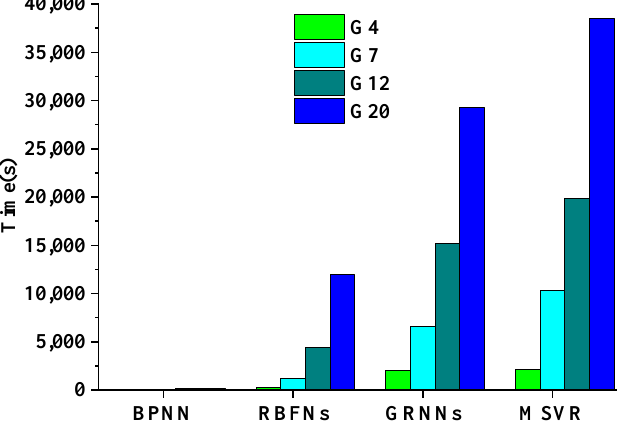
Figure 5. Time required for the training process by the machine learning methods with different sample sizes.